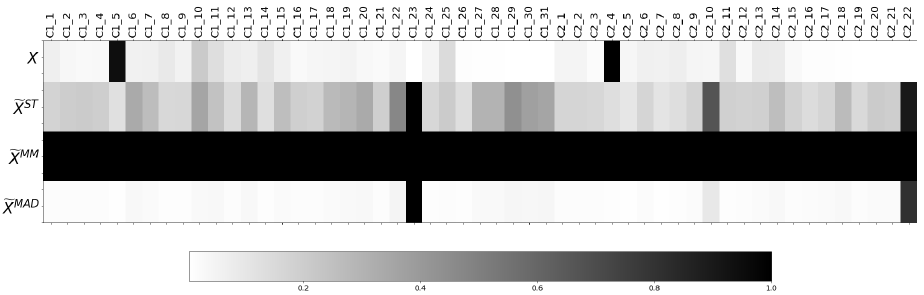
Figure 9. Normalised ranges of the features of the raw and the normalised dataset ( X , (cid:101) X ST , (cid:101) X MM and (cid:101) X MAD